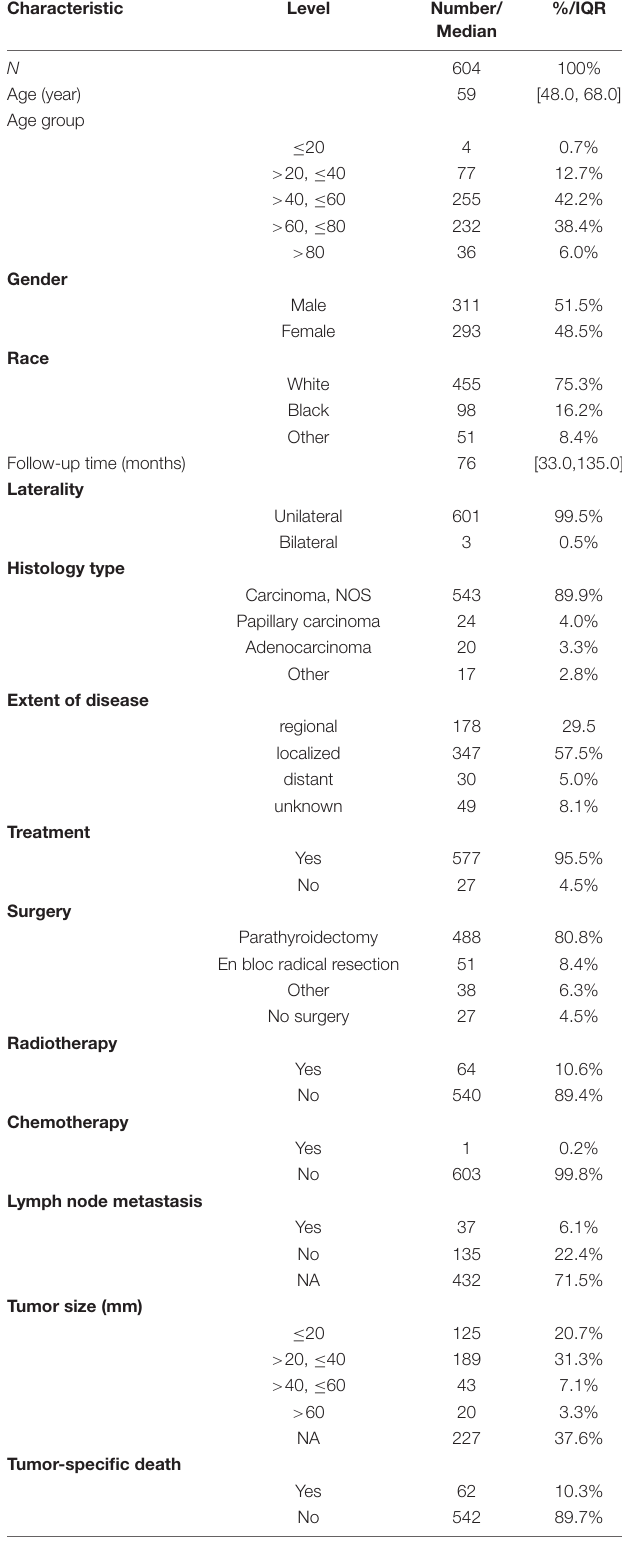
TABLE 1 | Demographics and clinicopathological characteristics of all patients with parathyroid carcinoma.